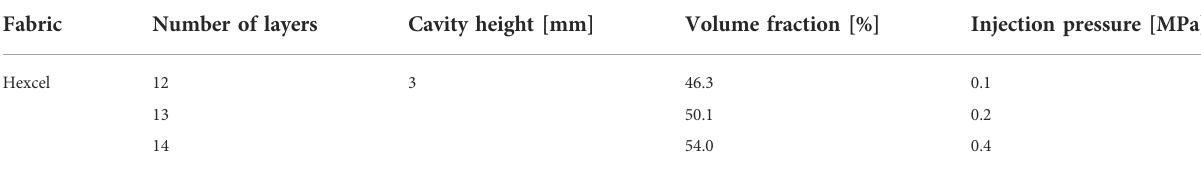
TABLE 1 Test procedure, adhering to the benchmark requirements (May et al., 2019).